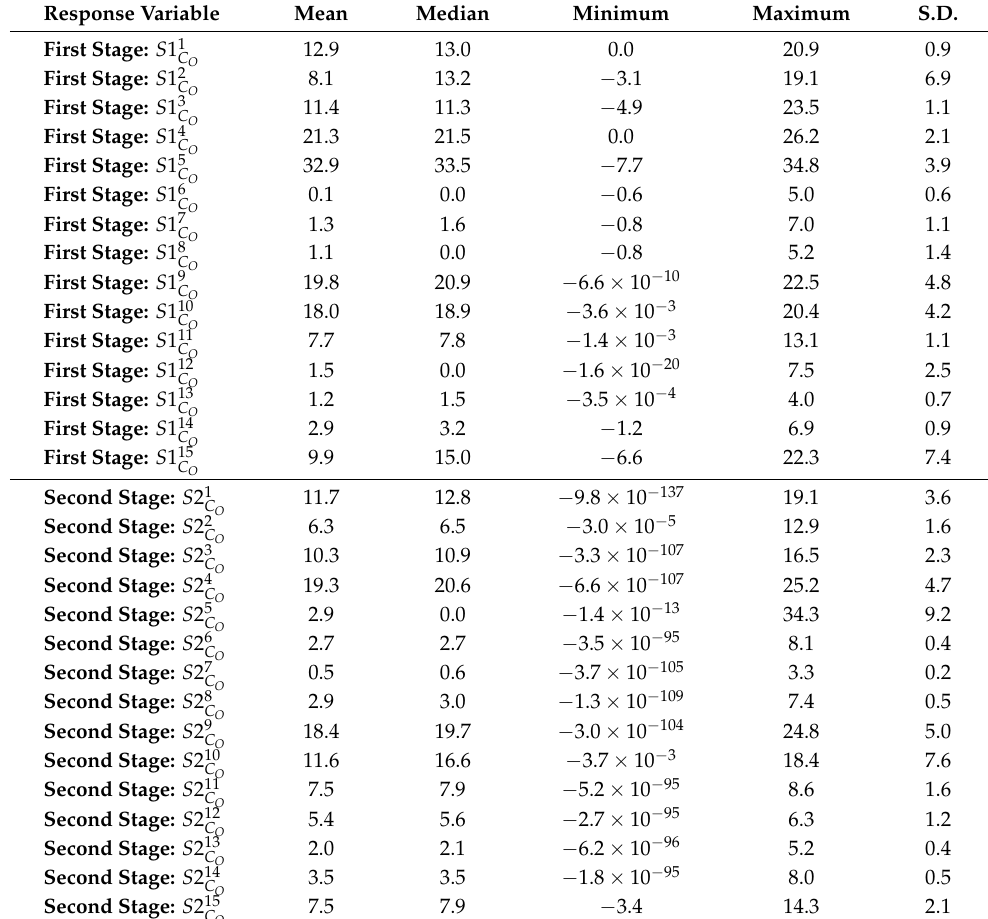
Table 2. Descriptive statistics of the response variables (non-normalized) from the data